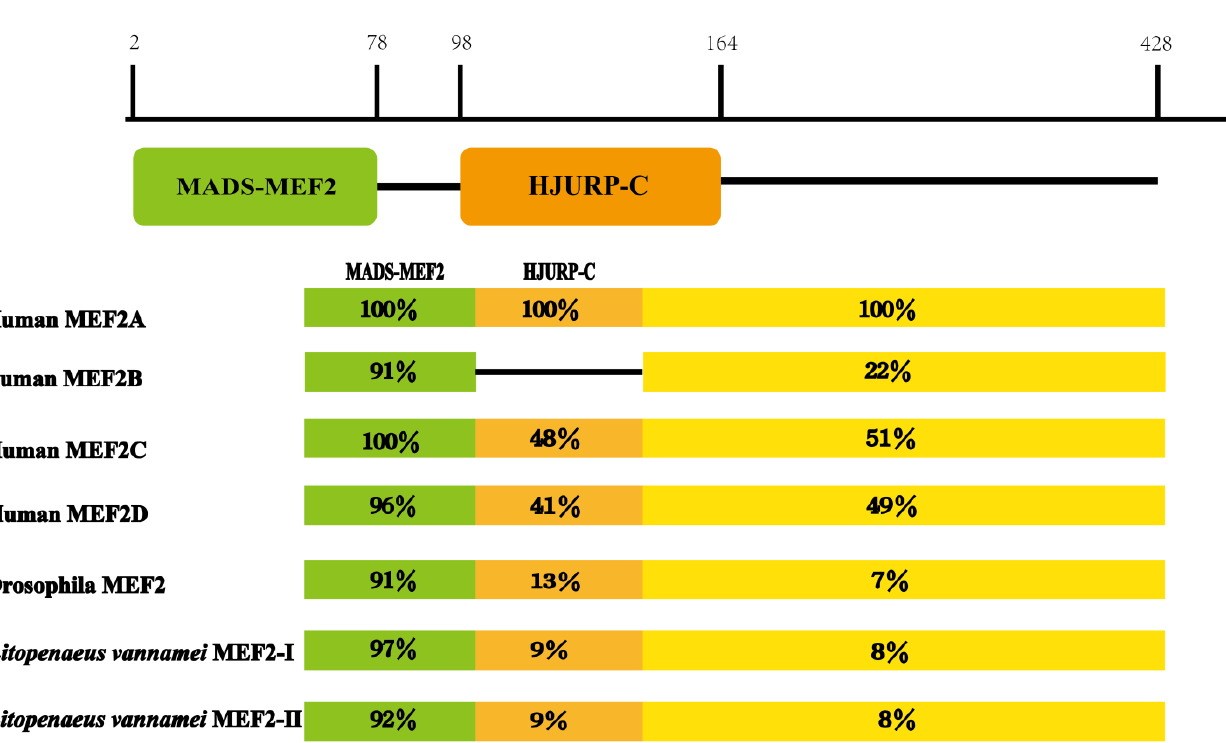
Figure 2. Deduced LvMEF2 domain composition and comparison with Drosophila and human. ( A ) Functional domain composition of MEF2 in L. vannamei . The black horizontal lines refer to the positions of amino acids that are not part of the functional domain. ( B ) Predicted MEF2 proteins of L. vannamei were compared with Drosophila and human. Numbers represent the similarity of the domains; human MEF2A is used as a molecular model in the ( B ), and the black horizontal line shows that MEF2B has no HTURP - C domain. The green blocks refer to MADS - MEF2 domain, the orange blocks refer to HTURP - C domain, the yellow blocks refer to the C - terminus.